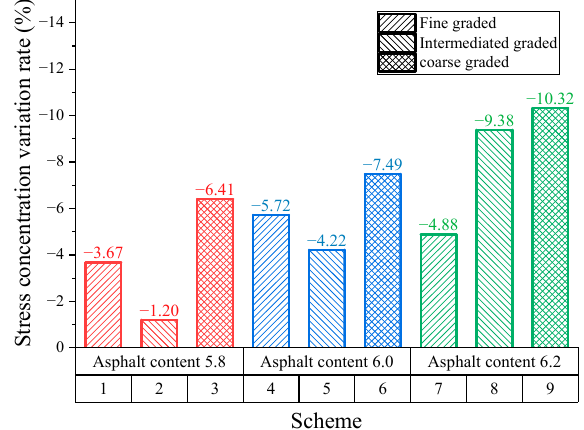
Figure 13. Results for contact stress concentration variation rate.